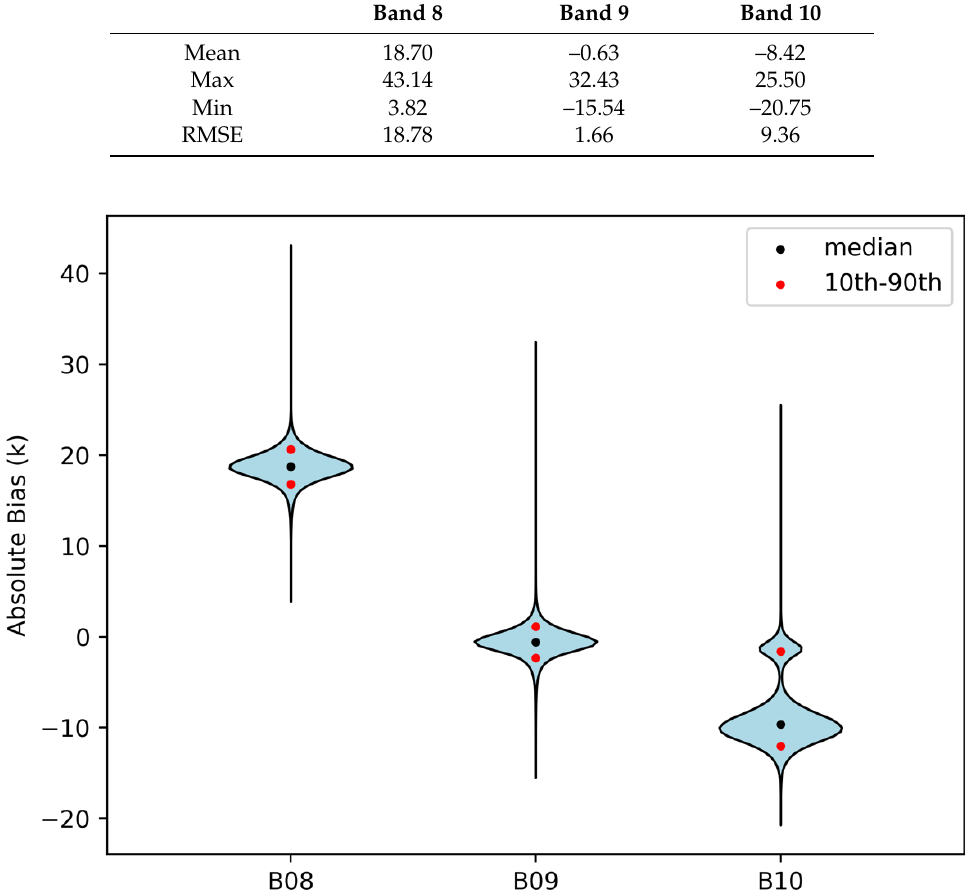
Figure 14. The violin plot of absolute biases between the AHI observations and simulated brightness temperatures for Band 8, Band 9 and Band 10. temperatures for Band 8, Band 9 and Band